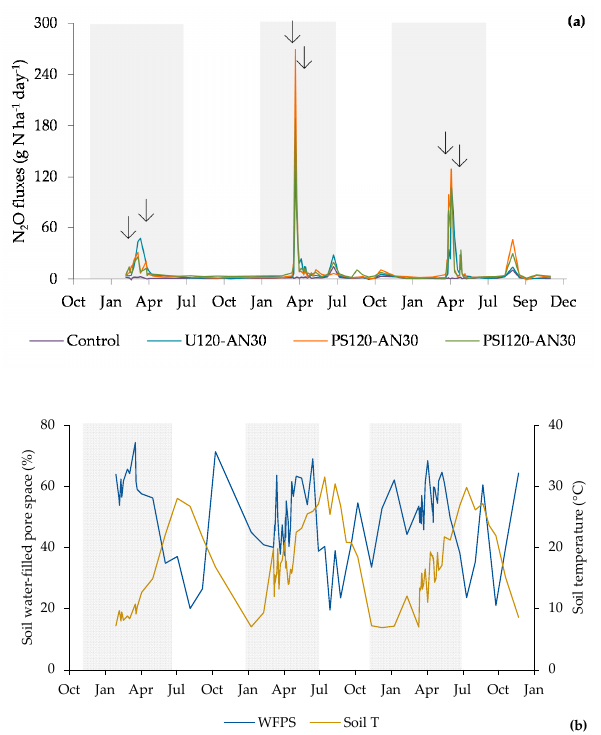
Figure 3. Temporal changes of ( a ) average N 2 O fluxes (g N ha − 1 day − 1 ; n = 4) for each fertilizer treatment (control, U120-AN30, PS120-AN30, and PSI120-AN30) ( b ) soil temperature (T, ◦ C) and water-filled pore space (WFPS, %) along the three growing seasons (2015 / 16, 2016 / 17, and 2017 / 18). Shadow areas show the period between presowing and harvest of each season. Arrows show fertilizer